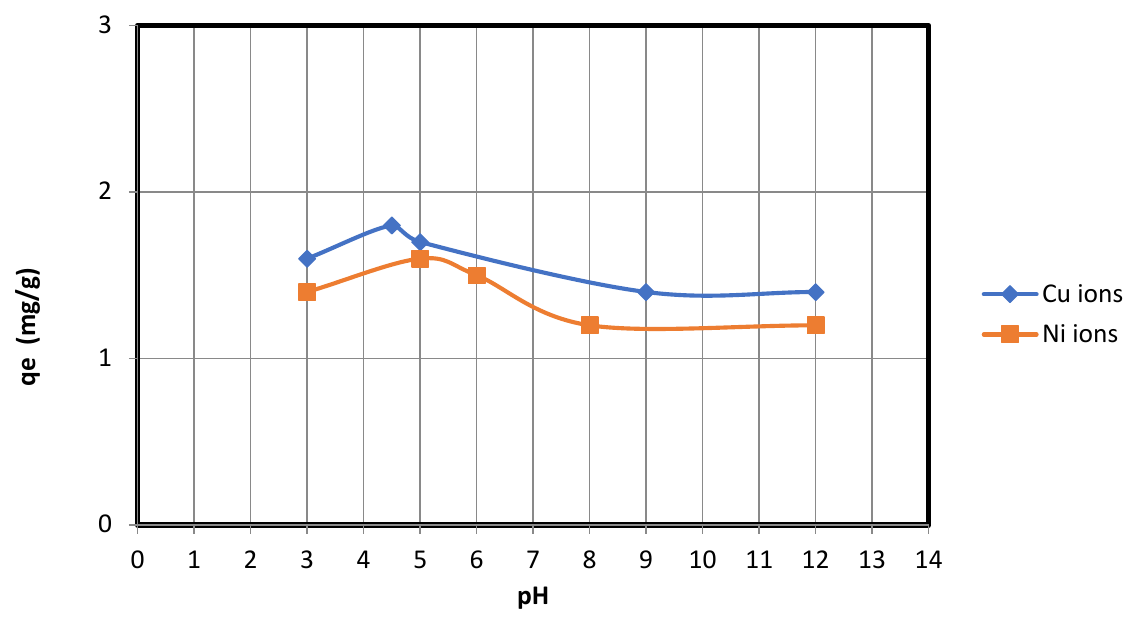
Figure 7. pH vs. qe for adsorption of Cu and Ni ions on nanocellulose.